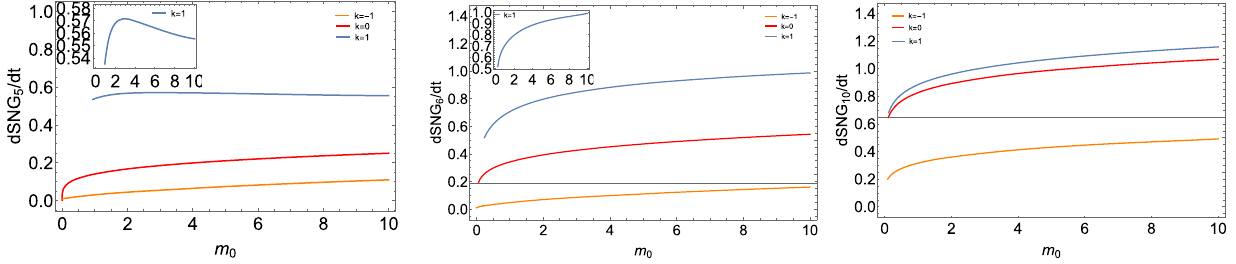
Fig. 5 Action growth v.s. string velocity for AdS black hole. From left to right, the dimension is 5 , 6 and 10. In all cases, we have set the black hole mass m 0 = 2